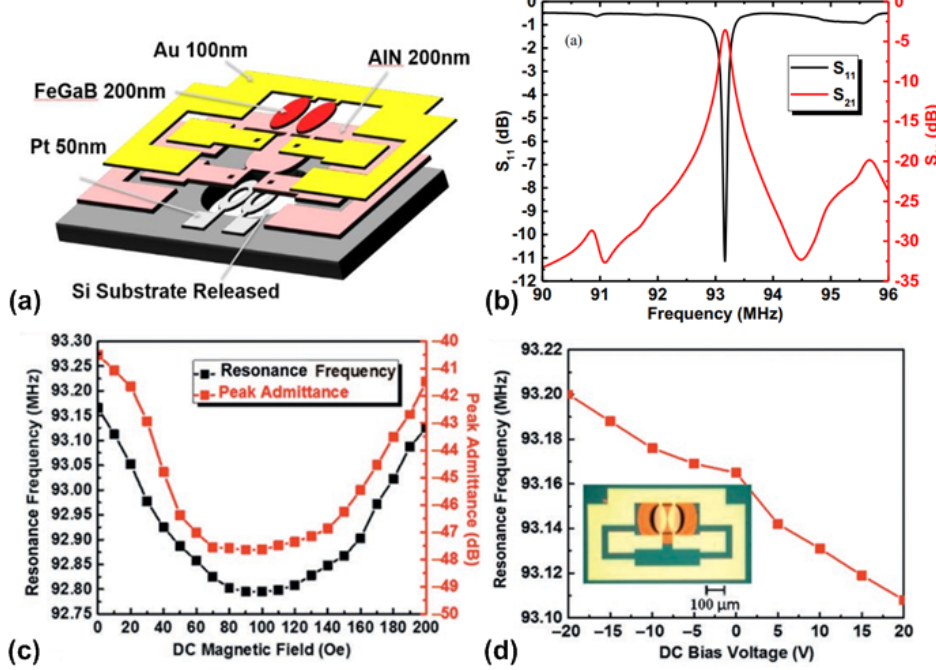
Figure 13. ( a ) Schematic of the tunable filter; ( b ) measured S 11 and S 21 of the tunable filter at zero bias field; ( c ) Measured resonant frequency as a function of DC magnetic field; ( d ) measured resonant frequency as a function of DC voltage across the thickness of the AlN film. This figure is reproduced from [153] (© 2016 IEEE).